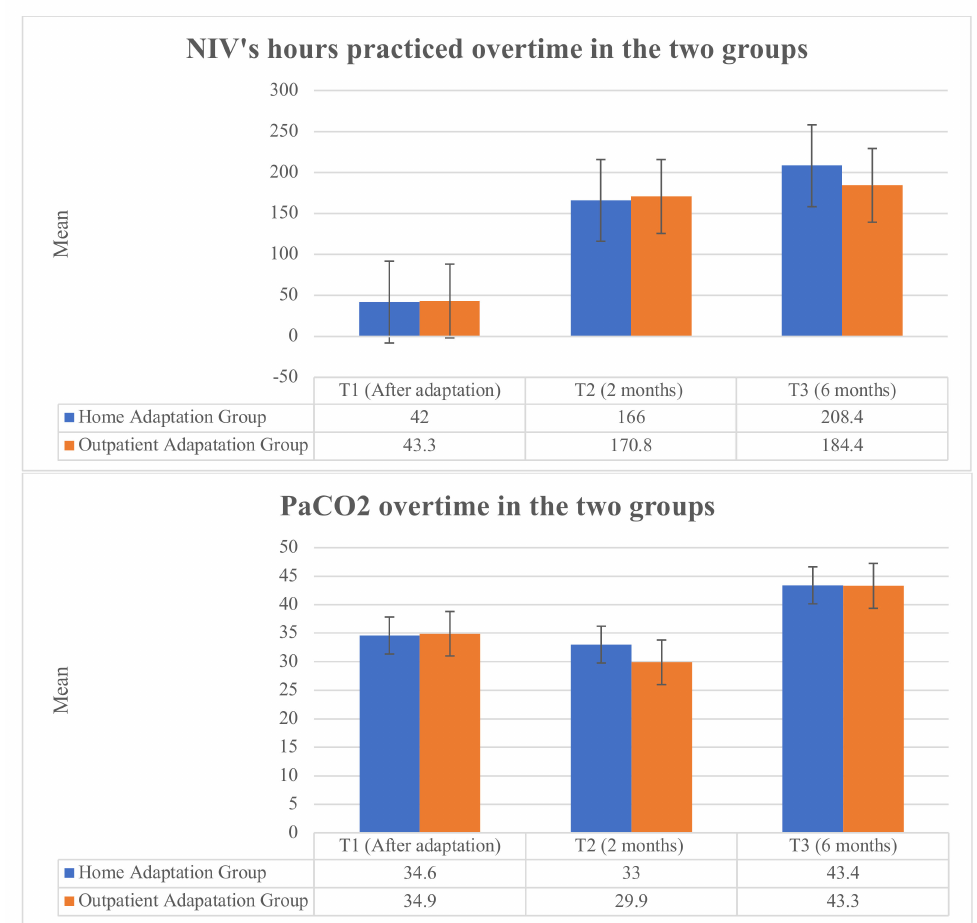
Figure 3. PaCO2 and NIV adherence (hours of NIV